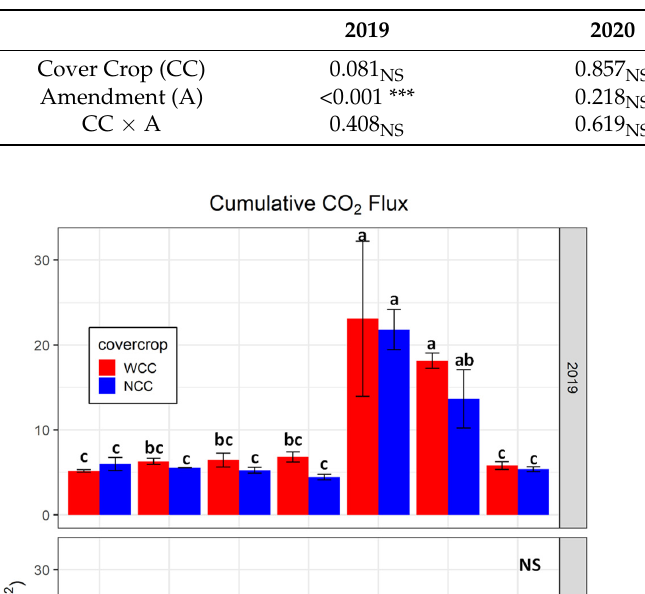
Table 5. Effects of cover crop, amendment and their interactions on cumulative CO 2 flux. The numbers presented in the table are p values from the ANOVA test. ***— p < 0.001, and NS—not significant.